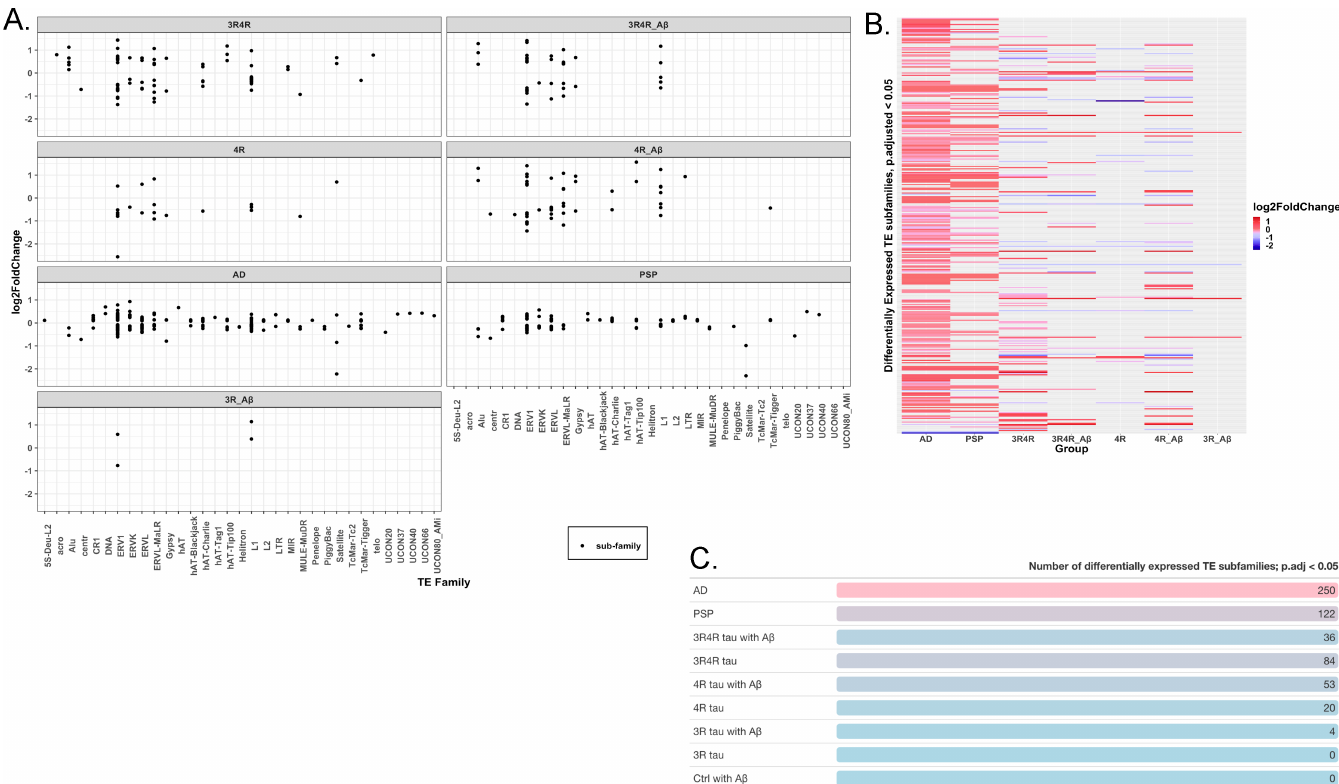
Fig 5. Patterns of transposable element expression at the subfamily level across human disease and cell samples. (A) Chart showing log-fold change in expression among subfamilies of significantly expressed (FDR-corrected p-value < 0.05) TEs per condition examined. Each dot represents a subfamily within each greater TE family (on the x-axis). (B) Heatmap displaying log-fold changes among subfamilies of significantly expressed (FDR-corrected p-value < 0.05) TEs between conditions examined. (C) Table showing numbers of significantly expressed (FDR-corrected p-value < 0.05) TE subfamilies per condition examined. All data presented here was analyzed using